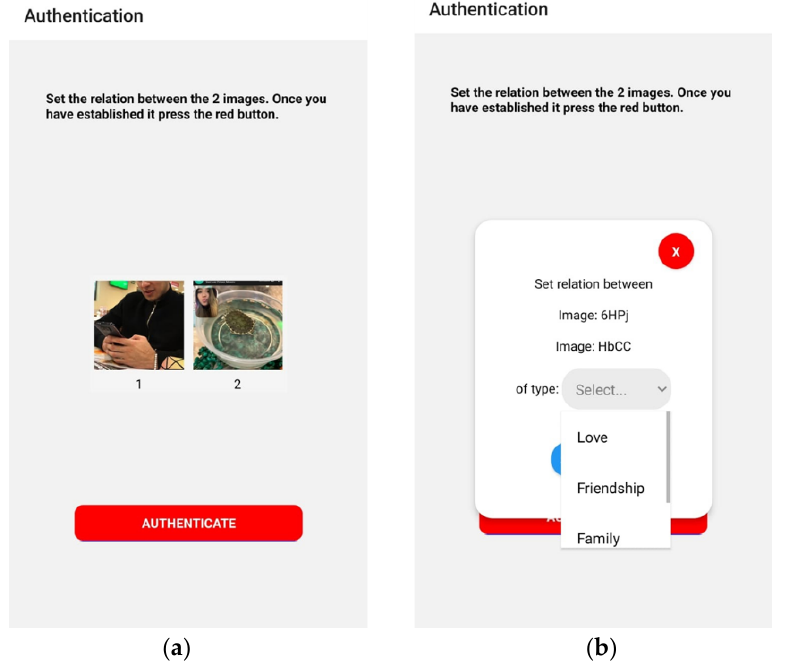
Figure 8. ( a ) Authentication screen; ( b ) Authentication screen with react native modal displayed.